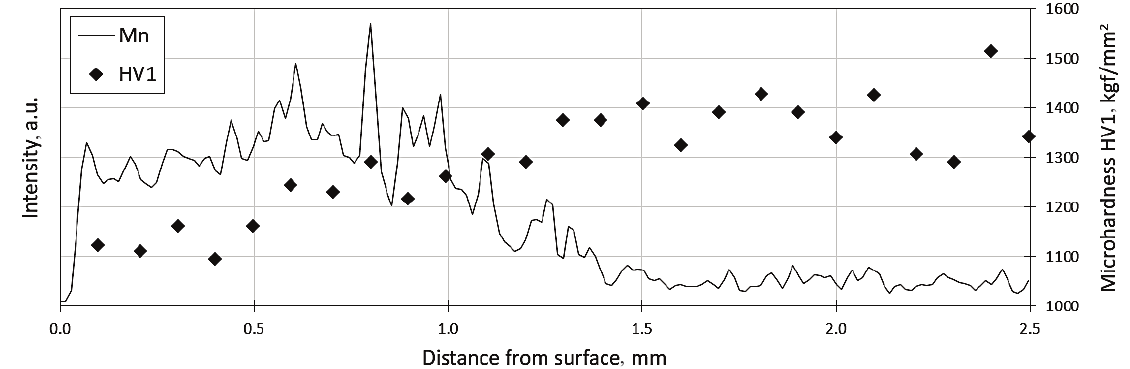
Fig. 2. The surface layer Mn content and microhardness profiles of TiC-FeCr cermet after alloying sintering in Mn-rich micro - atmosphere.